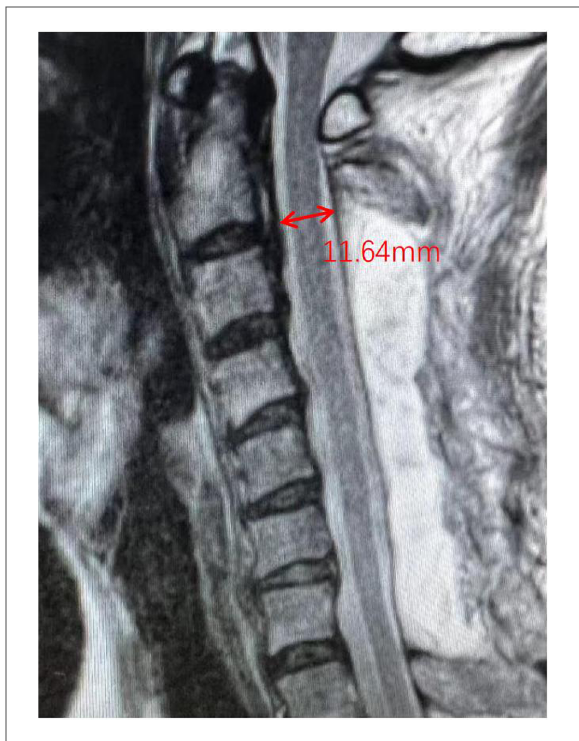
FIGURE 4 Schematic diagram ofC2/3durawidth. The width of C2/3 onMRI scan was evaluated. The dura width in schematic diagram was 11.64 mm.